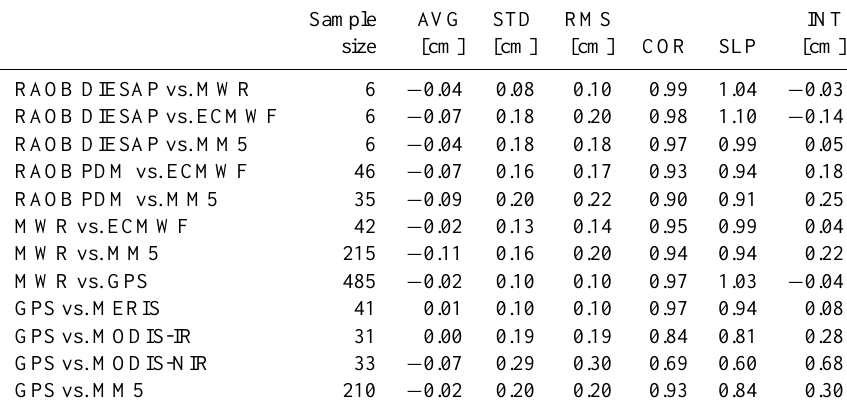
Fig. 4. Scatter plots of IWV from different sources. Left: the reference source is RAOB (top: at DIESAP; bottom: at PDM). Right: the reference source is MWR (top: MM5 and ECMWF; bottom: MM5 and GPS). The mean x-y difference (AVG), the standard deviation (STD) and root-mean-square (RMS) differences, the correlation coefficient (COR), and finally the slope (SLP) and intersect (INT) of a least-square linear fit are reported. Values for AVG, STD, RMS values are in cm. Table 2. Summary of IWV statistics extracted from the scatter plots in Figs. 4 and